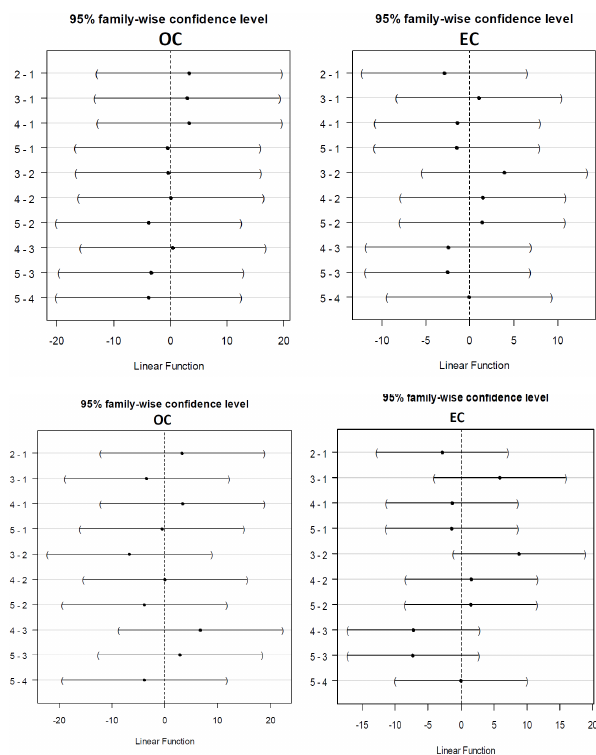
Figure 2. One-way ANOVA test to compare laboratory pairs for OC and EC measurement. Top graphs contain results from laboratory 3 in transmittance. Bottom graphs contain results from laboratory 3 in reflectance.